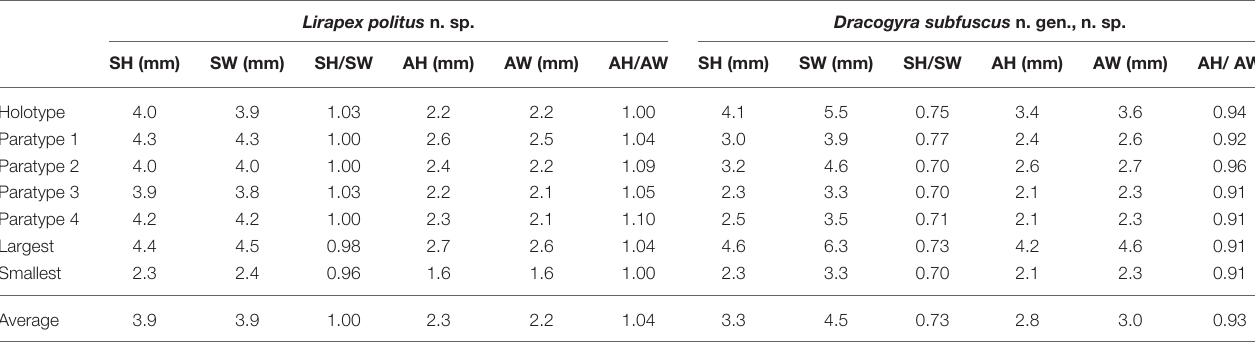
TABLE 2 | Shell parameters of Lirapex politus n. sp. and Dracogyra subfuscus n. gen., n. sp. Lirapex politus n.